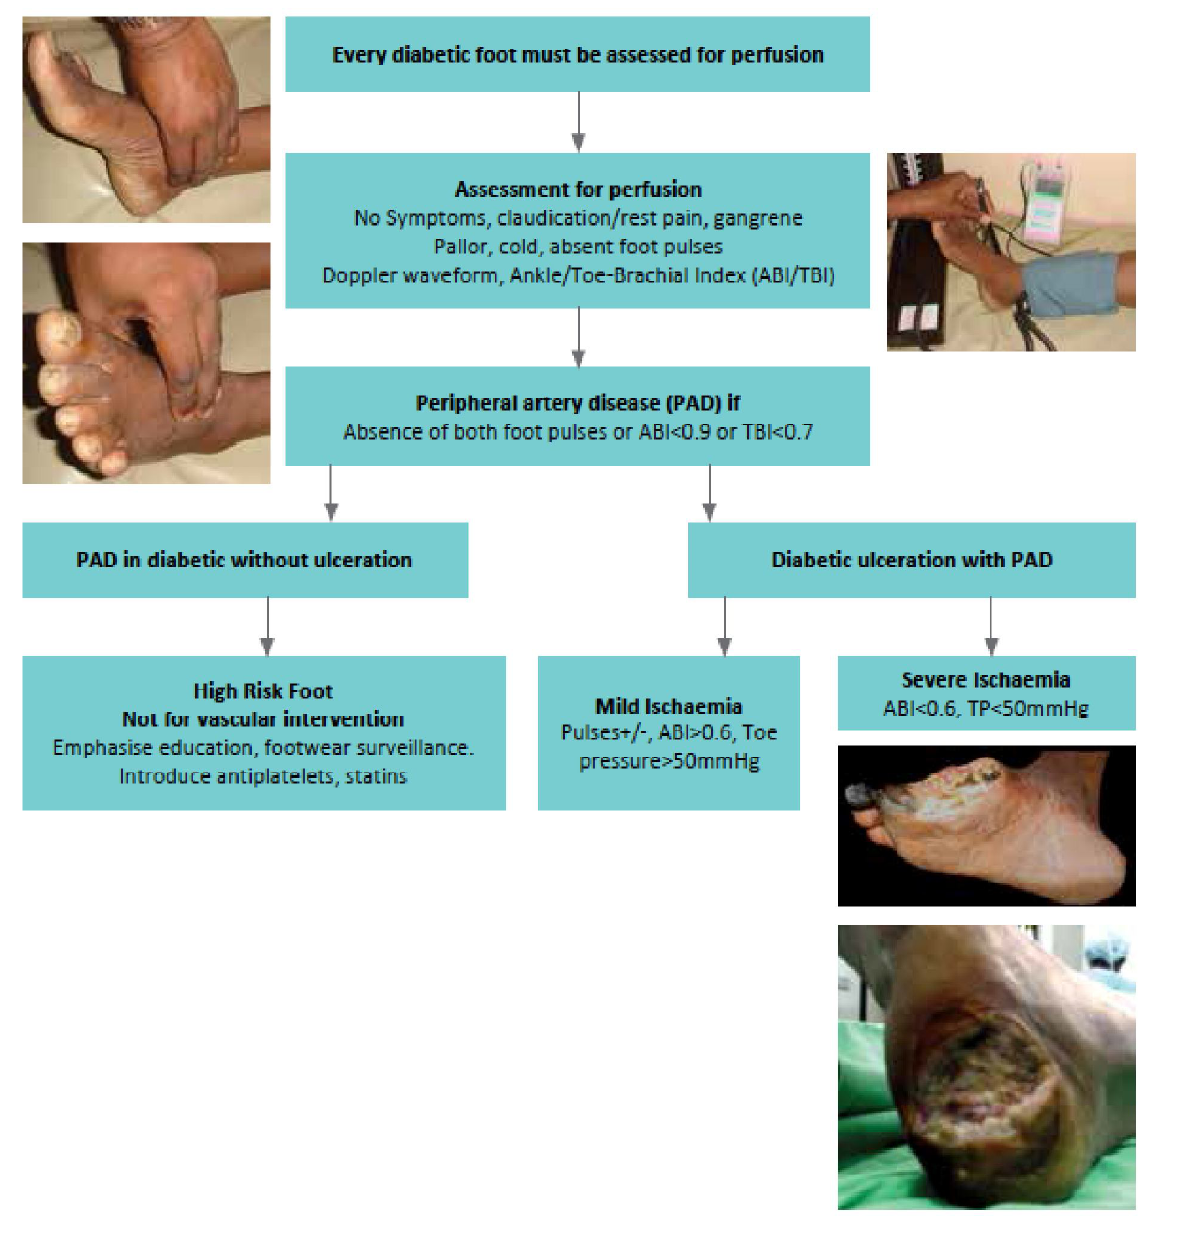
Figure 11. Flowchart of Vascular